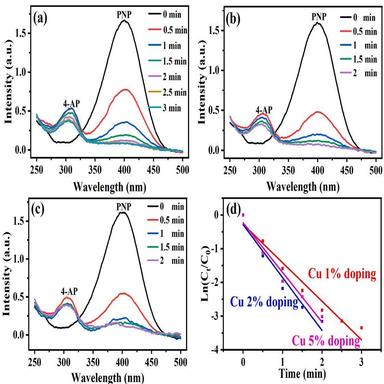
UV–vis absorption spectra for the hydrogenation reduction reaction of PNP over the 1%Cu2+-Co3O4/NC-glycerol-600 (a), 2%Cu2+-Co3O4/NC-glycerol-600 (b), 5%Cu2+-Co3O4/NC-glycerol-600 (c) materials, and pseudo first-order linear fit results (d) where the molar ratio of NaBH4:PNP was 100:1 and the masses of the catalysts were 0.05 mg.